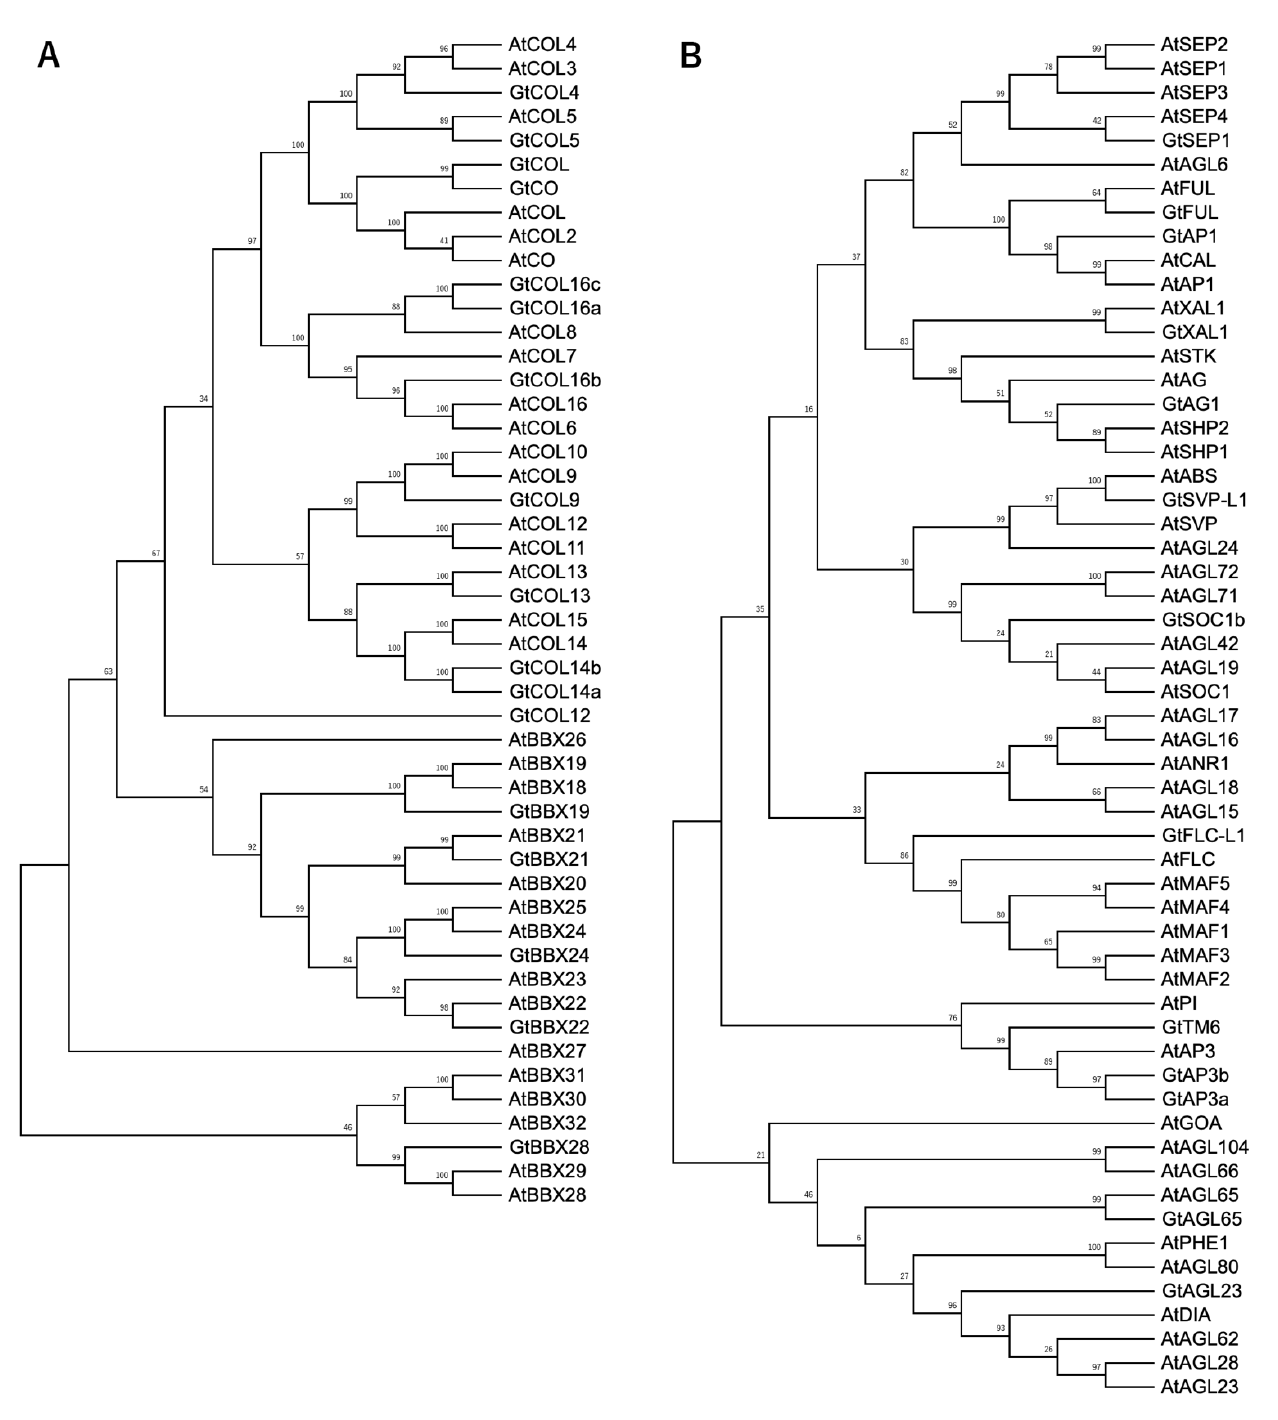
Figure 2. Phylogenetic analysis of BBX and MADS-box proteins in gentians and Arabidopsis thaliana . ( A ) Phylogenic tree of BBX family proteins in gentians and A. thaliana . ( B ) Phylogenic tree of MADS- box family proteins in gentians and A. thaliana .